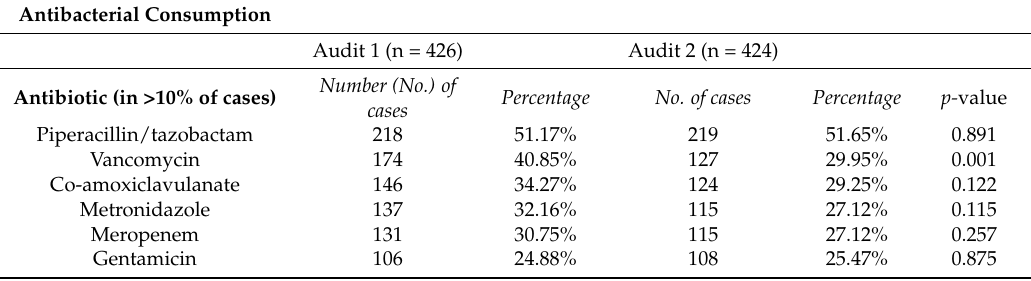
Table 2. Antibiotic consumption and duration comparisons between study